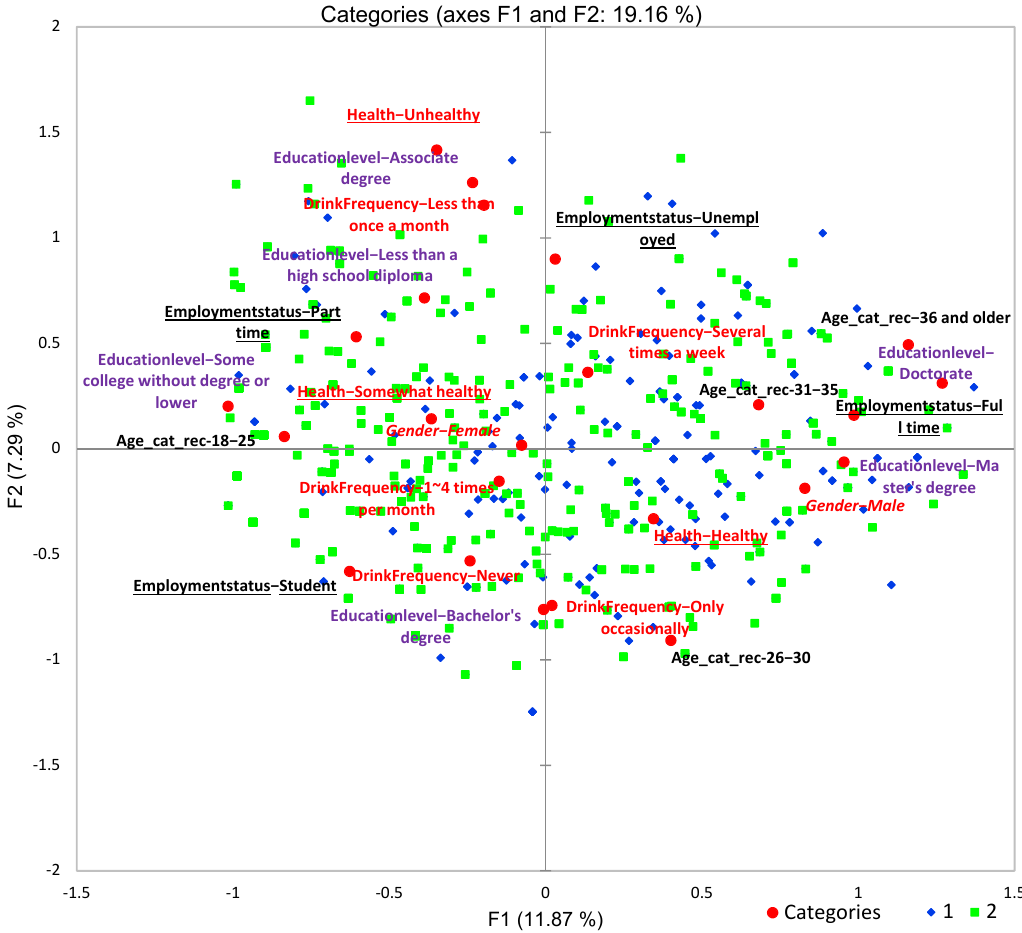
Figure 15. Multiple correspondence analysis (MCA) of two clusters of consumers (blue diamonds represent cluster 1 with n = 410 and green squares represent cluster 2 with n = 491) characterized by six demographics (gender, age, health condition, drink frequency, education level, and employment status) in different colors and fonts.